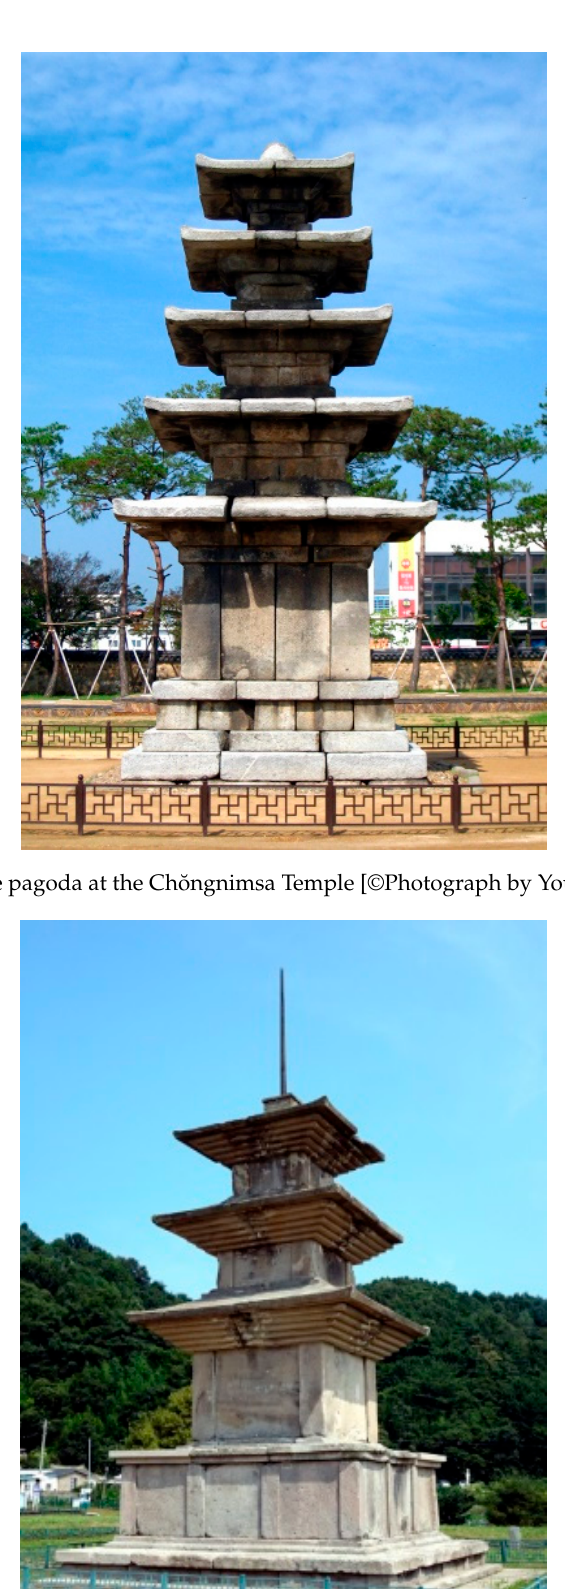
Figure 3. The composition and term definitions of the pagoda, in the example of the S ŏ kkat’ap Pagoda at the Pulguksa Buddhist Temple (Ky ŏ ngsik Pak 2008; the authors newly re-modify the figure in the paper by Yavartanoo and Kang 2017). 2. Discussing the Points at Issue in Jiuzhang Suanshu and Zhoubi Suanjing The Zhoubi Suanjing is generally considered the oldest of the mathematical classics in ancient China since the Jiuzhang Suanshu is much fuller and represents a much more advanced state of mathematical knowledge than the Zhoubi . 5 As the safest assumption on the publication date, if the 5